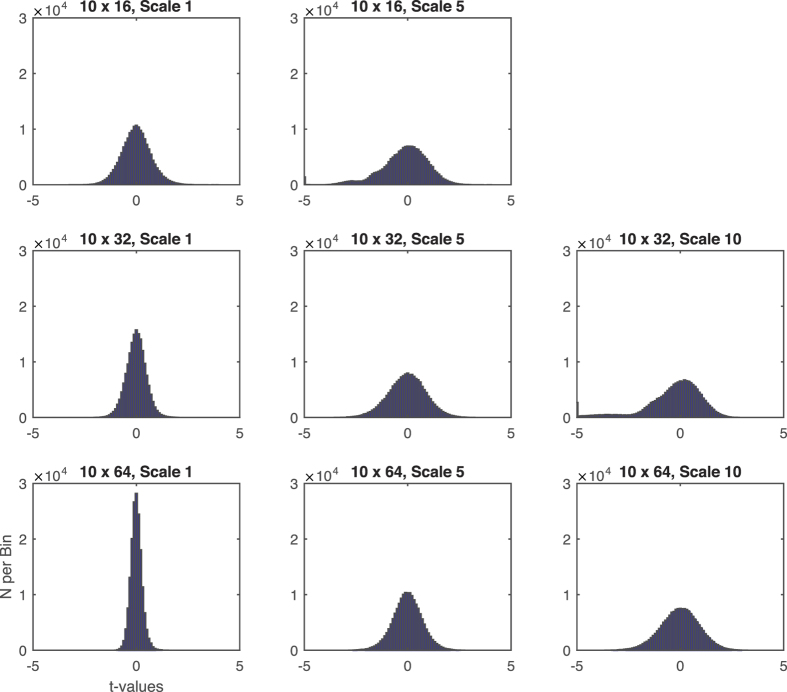
fMRI: t value distributions of comparing voxel-wise accuracy with overall accuracy (for exemplary j × n combinations and scales).Regardless of the number of data segments, data points per segment, and time scale, deviation of the voxel-wise accuracy from overall accuracy were effectively zero-centered, with tighter and more symmetric distributions at higher data densities (scale 1 vs. higher scales; lower vs. higher number of data points per segment).